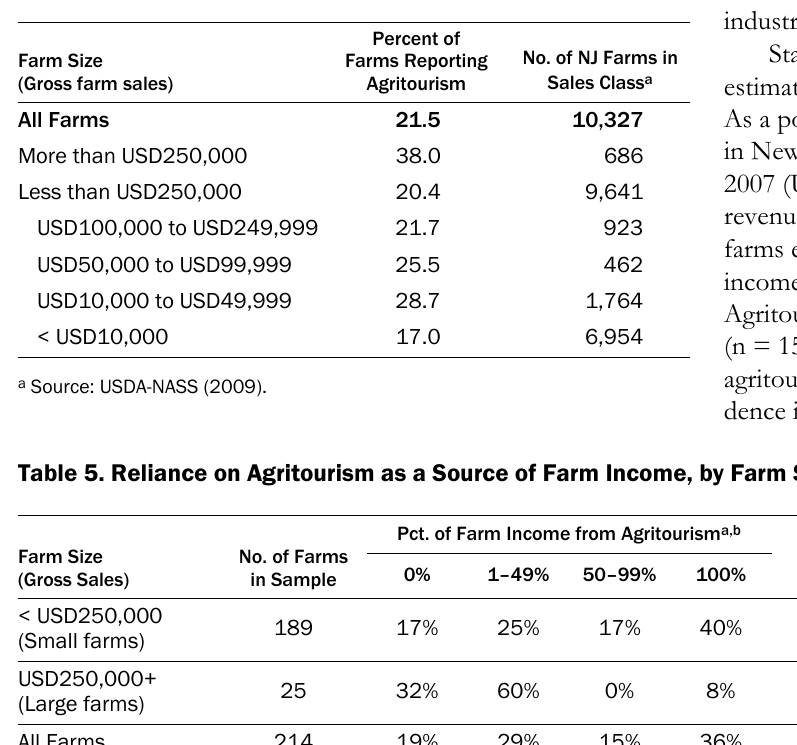
Table 4. Involvement in Agritourism by Farm